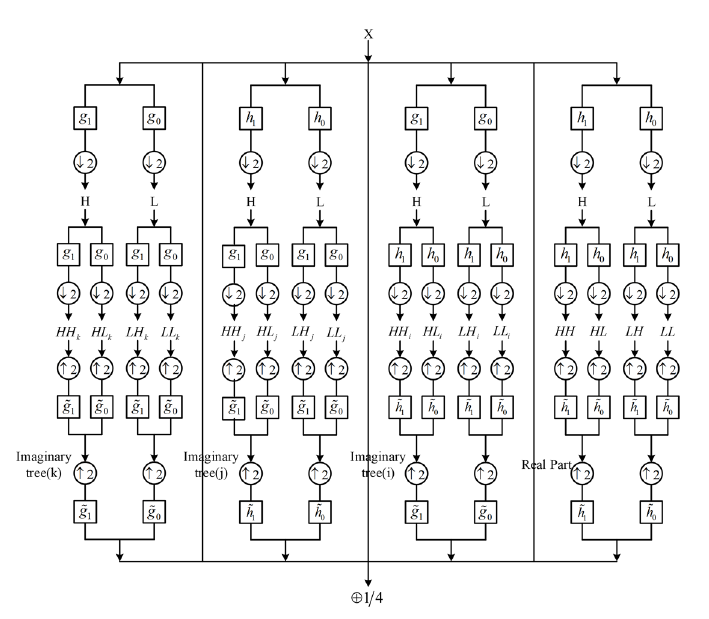
Figure 3. Symbols and meanings for QWT algorithm. The noise variance